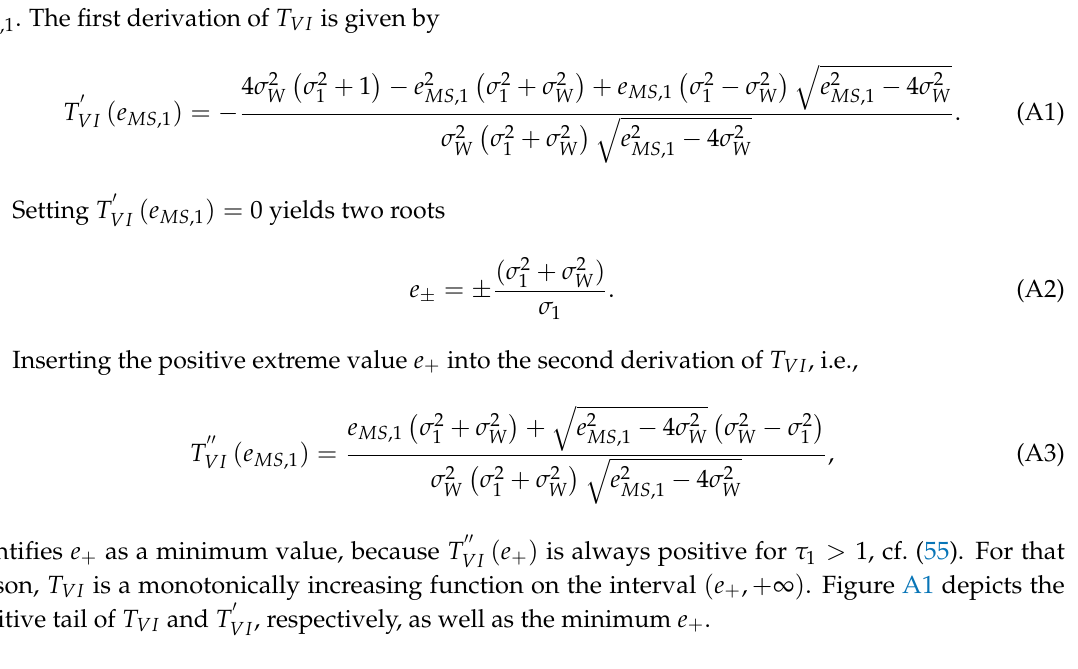
for positive values of e MS ,1 as well as VI